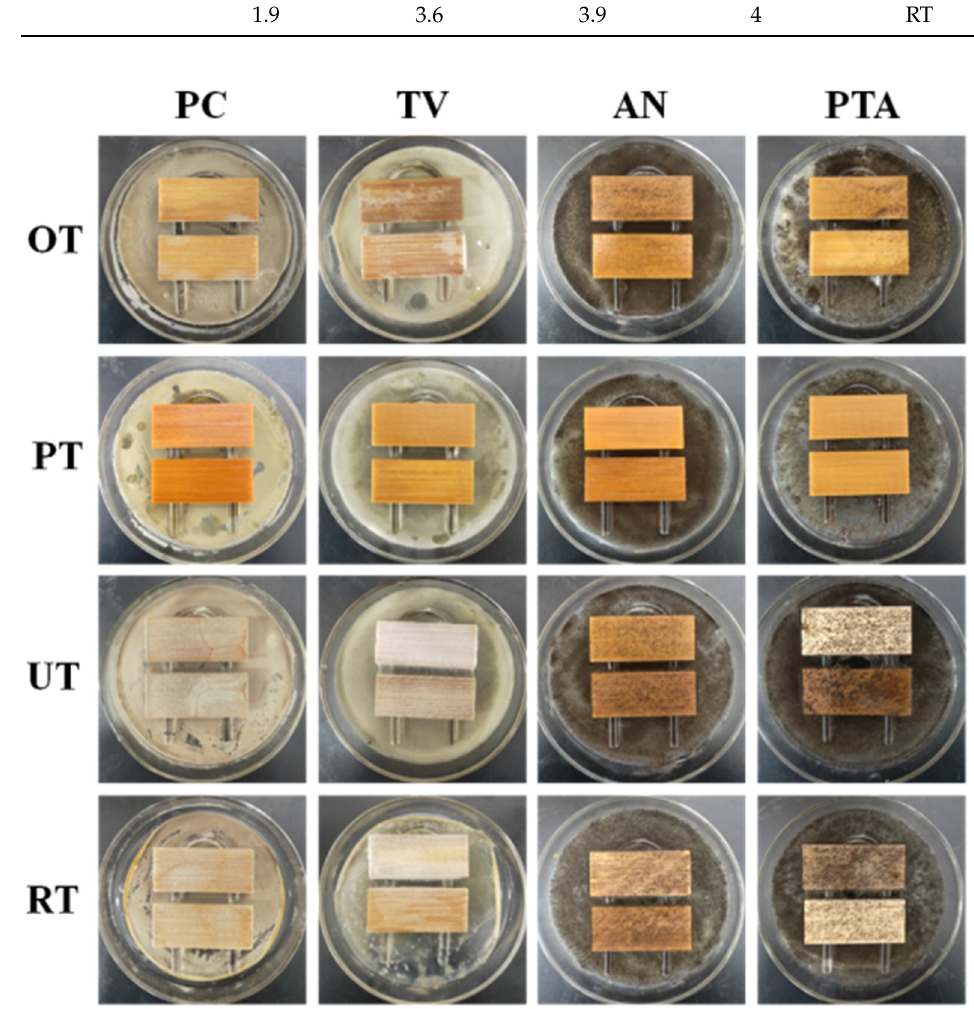
Figure 8. Mould control results of bamboo strips after 28 days. Table 4. Infection grade of bamboo strips during mould control.